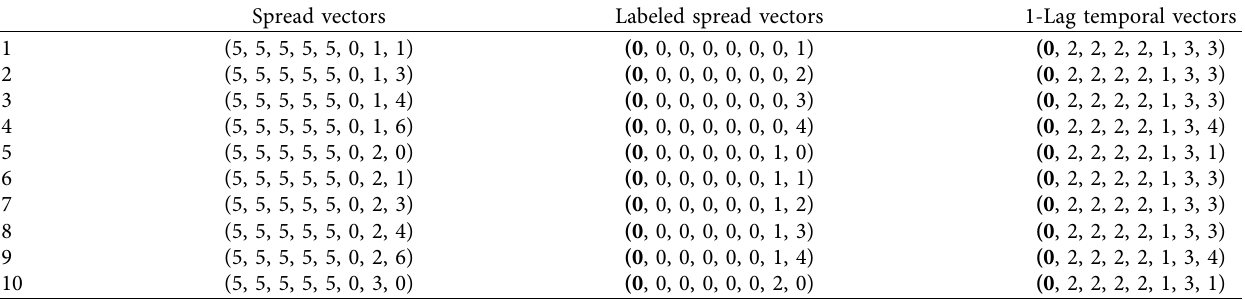
Table 13: Labeled spread vectors and 1-LAG temporal vectors. Spread vectors Labeled spread